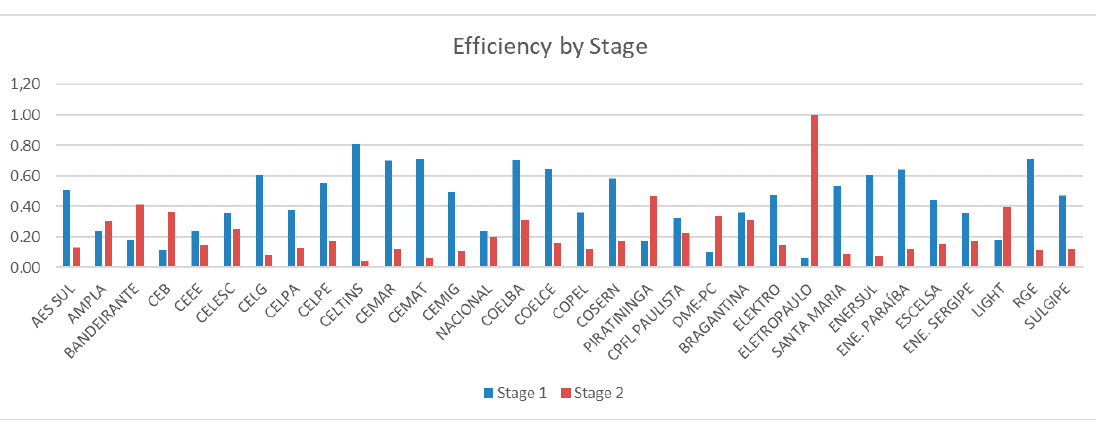
Figure 7. Efficiency of each concessionaire by stage.